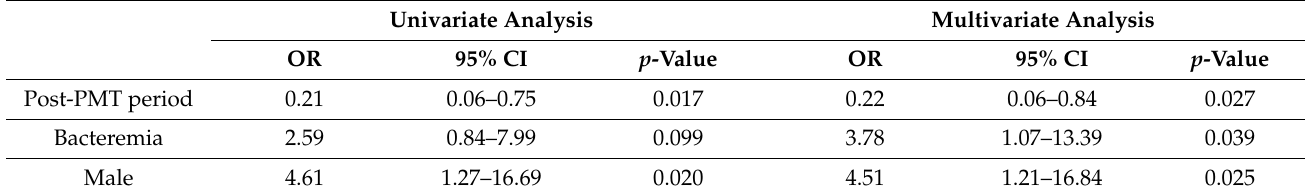
Table 3. Multivariate analysis on 30-day infectious diseases